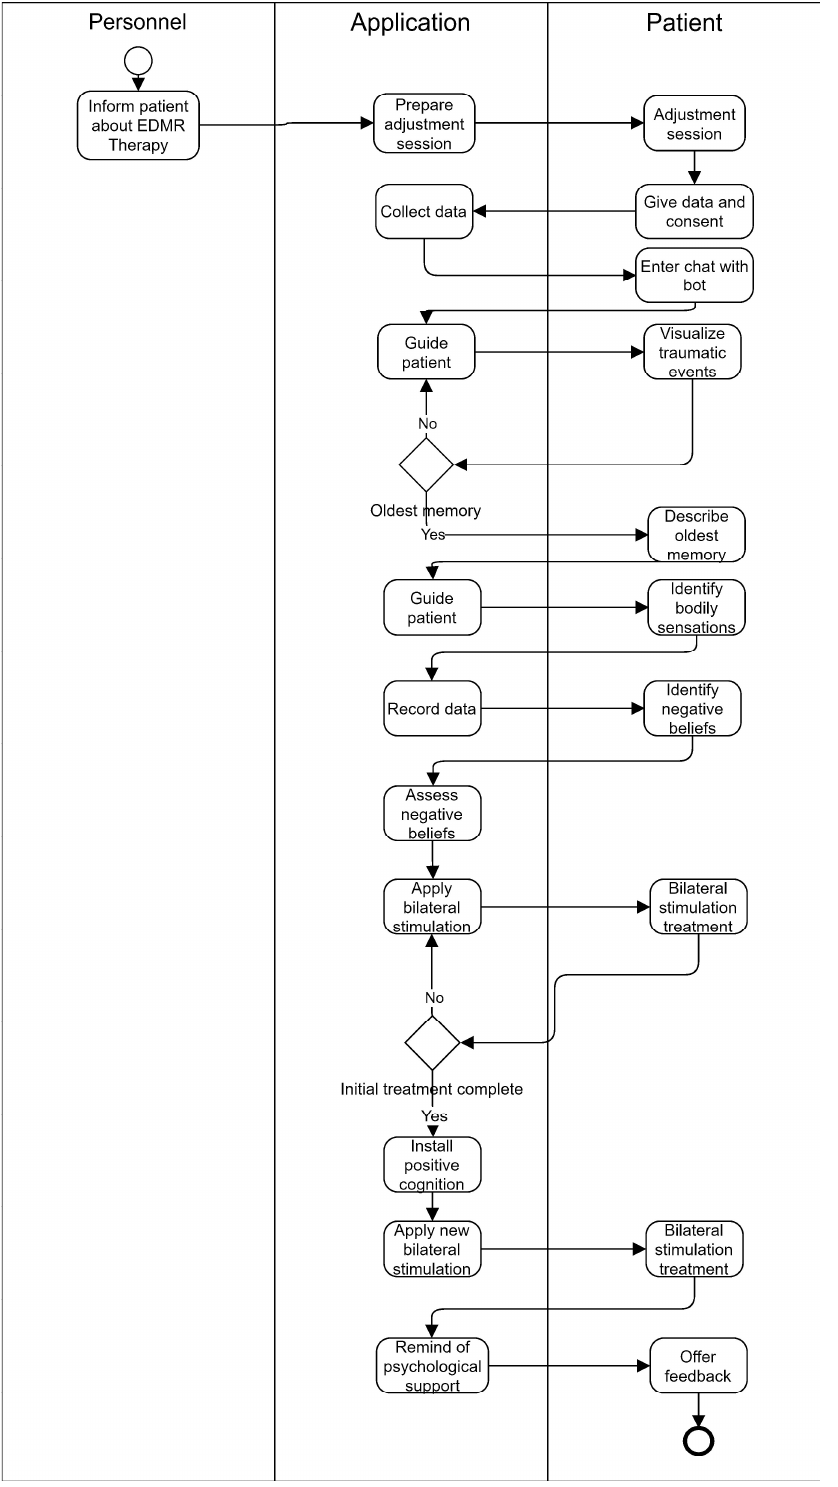
Figure 6. The representation of the applied application protocol.